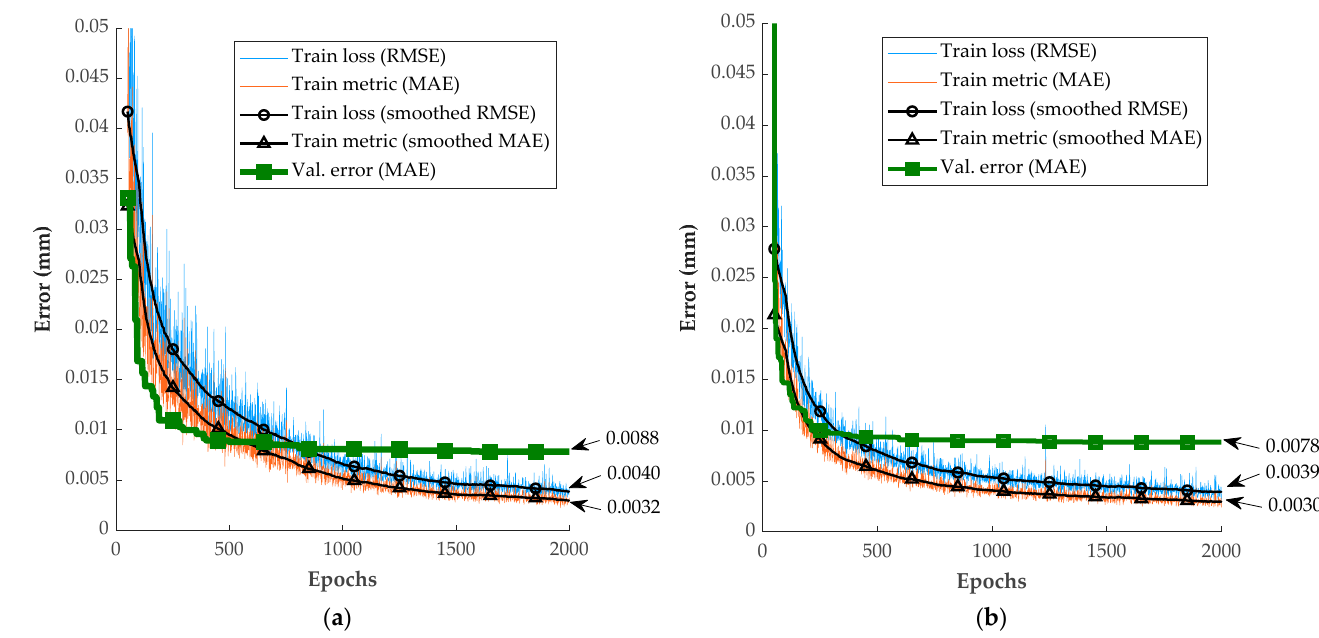
Figure 12. Training processes: ( a ) Strategy 1; ( b ) Strategy 2.